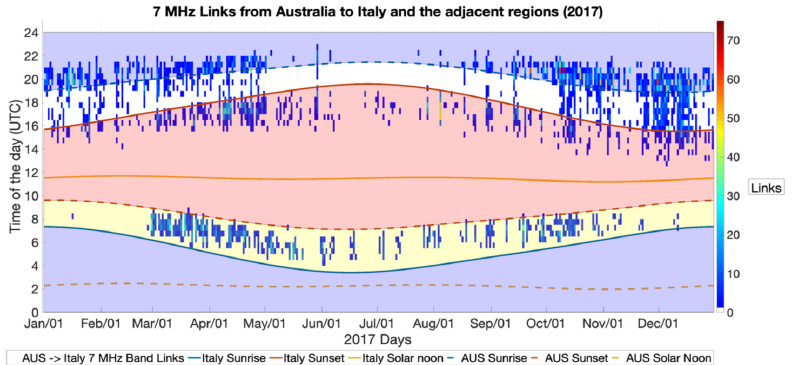
Figure 16. The 7 MHz radio links made from the Eastern Australia to Italy and the adjacent regions in 2017. The blue shaded area is the Australian daytime hours. The red area is the UK daytime hours. The yellow shaded area is the common daytime hours, and the white shaded area is the common night hours. The colours indicate the number of links available in each half-hour interval.